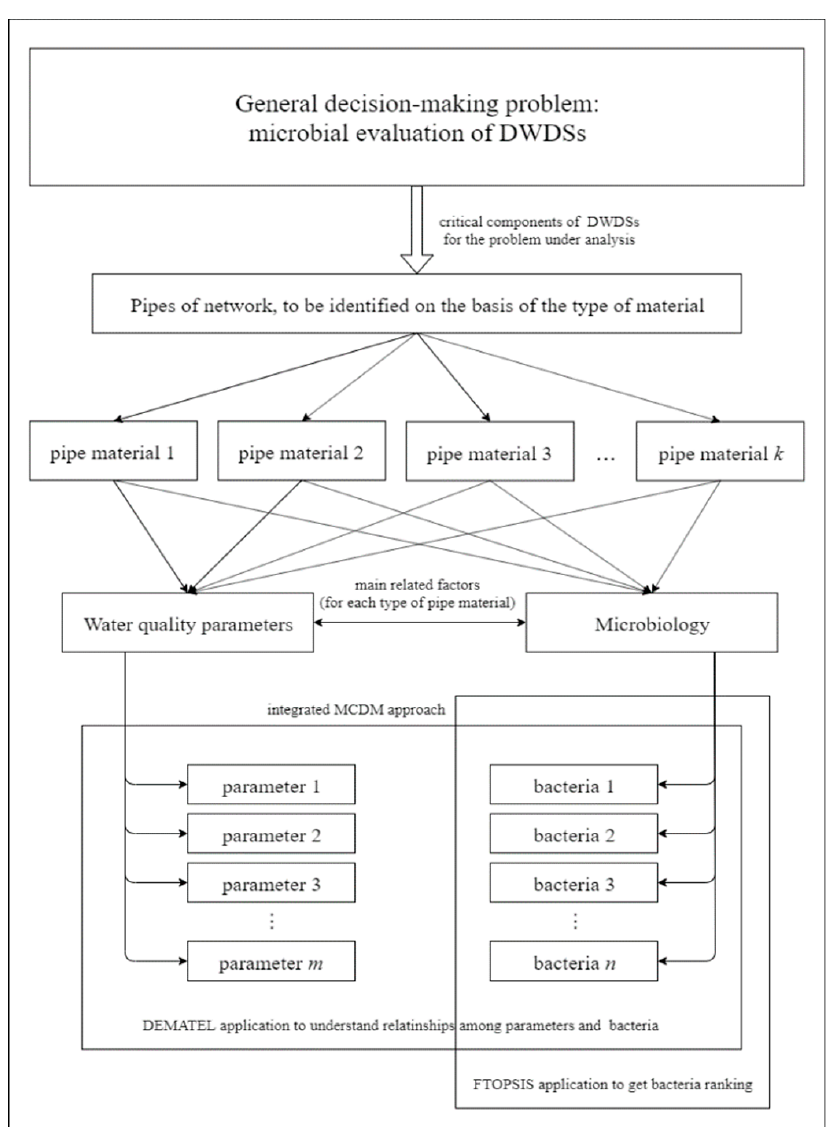
Figure 1. Flowchart representing the proposed approach.